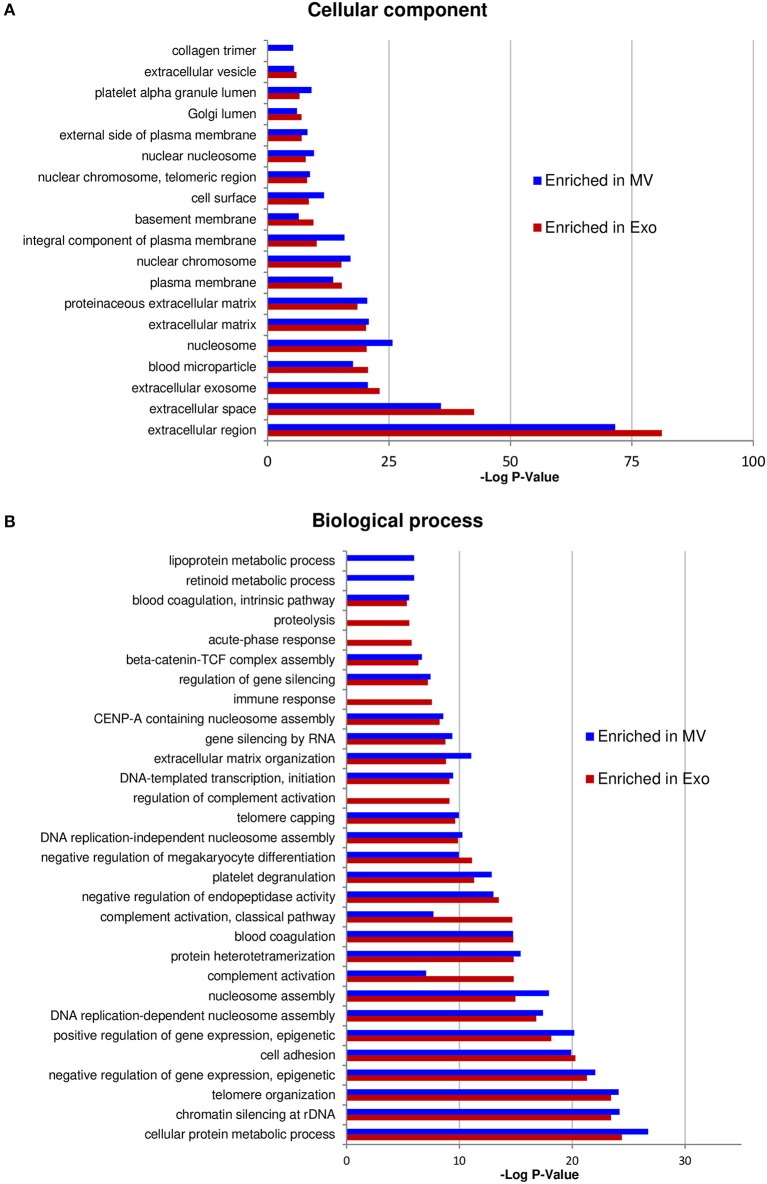
Analysis of proteins enriched in NKExo and/or NK-cell-derived microvesicles (NKMV). Gene Ontology (GO) annotation of proteins overexpressed in NKExo and identified in NKExo or NKExo plus NKMV (enriched in Exo) and proteins overexpressed in NKMV and identified in NKMV or in NKMV plus NKExo (enriched in MV). The significance [–log10(P-value)] for each GO term relative to cellular component (A) and biological process (B) is reported.